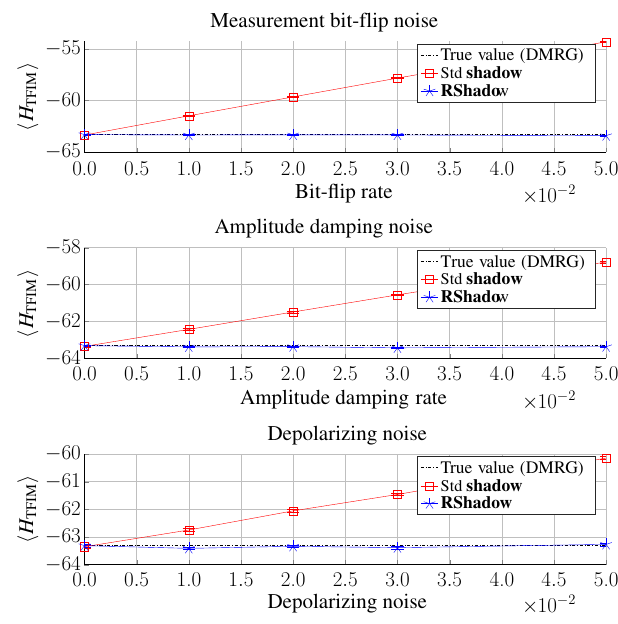
FIG. 5. Energy expectation estimation on a 50-spin 1D TFIM ground state.